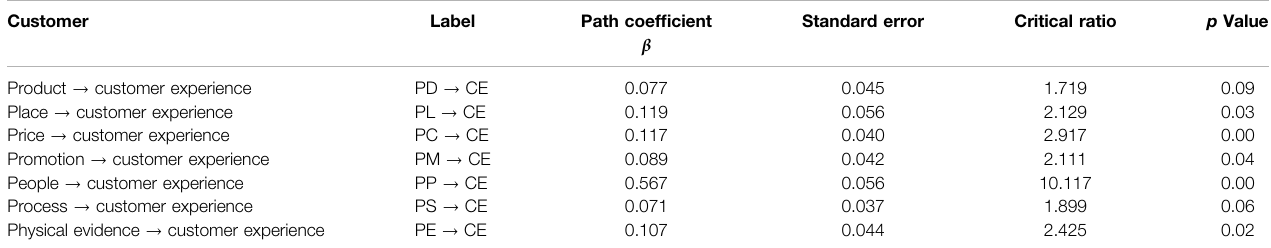
TABLE 11 | Path analysis for the supplier showing signi fi cant customer constructs. Customer